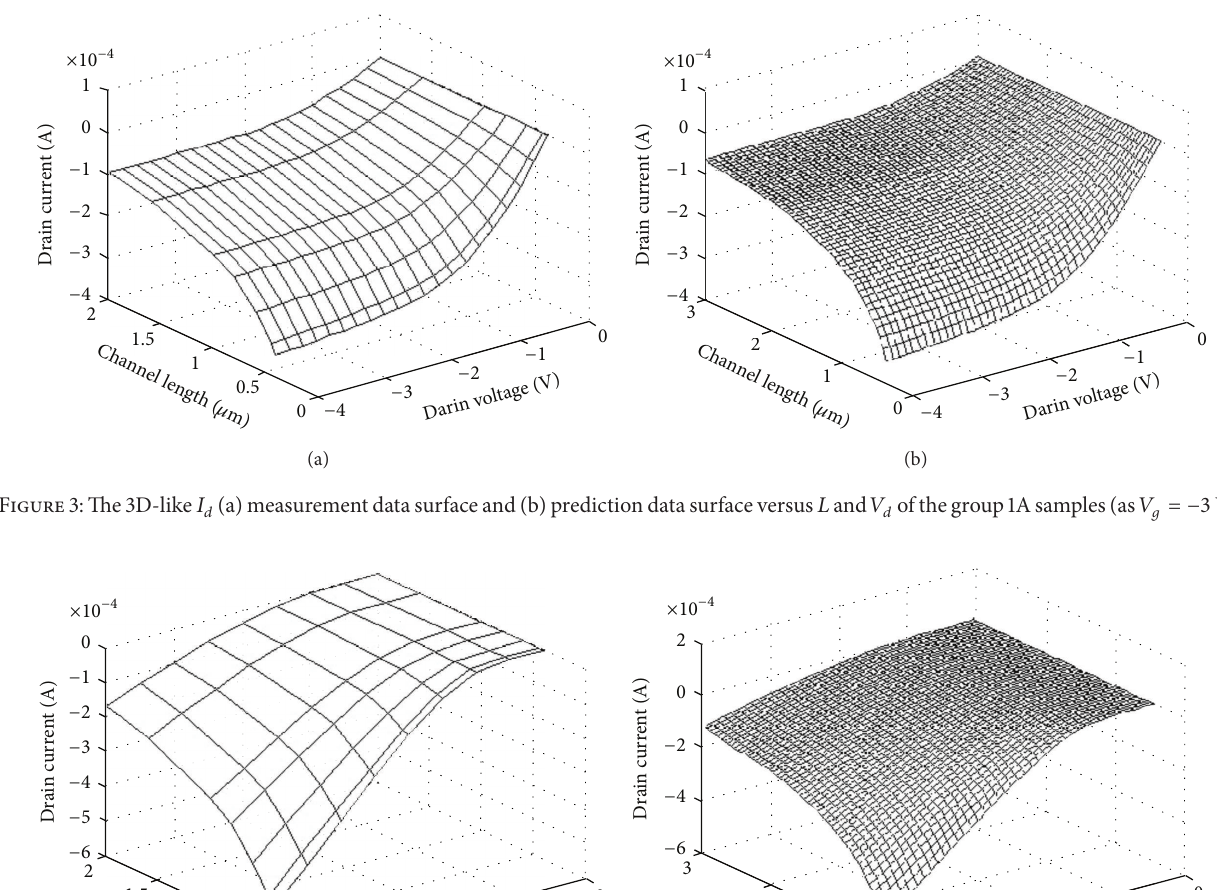
percentage of the predicted results was not greater than 0.1% when they were compared with the experimental